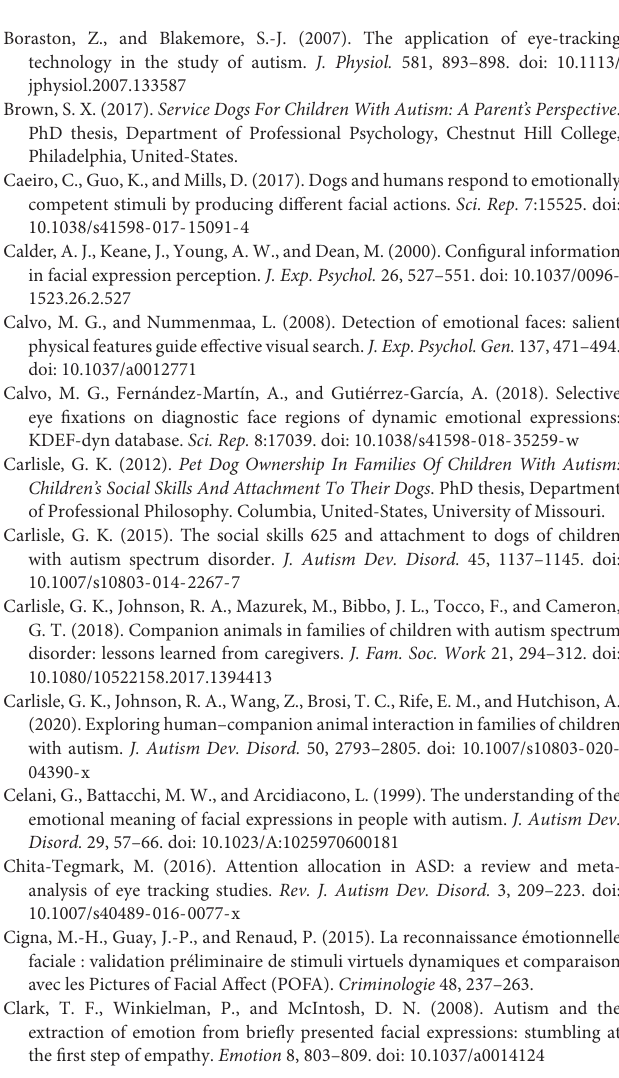
characteristics displaying